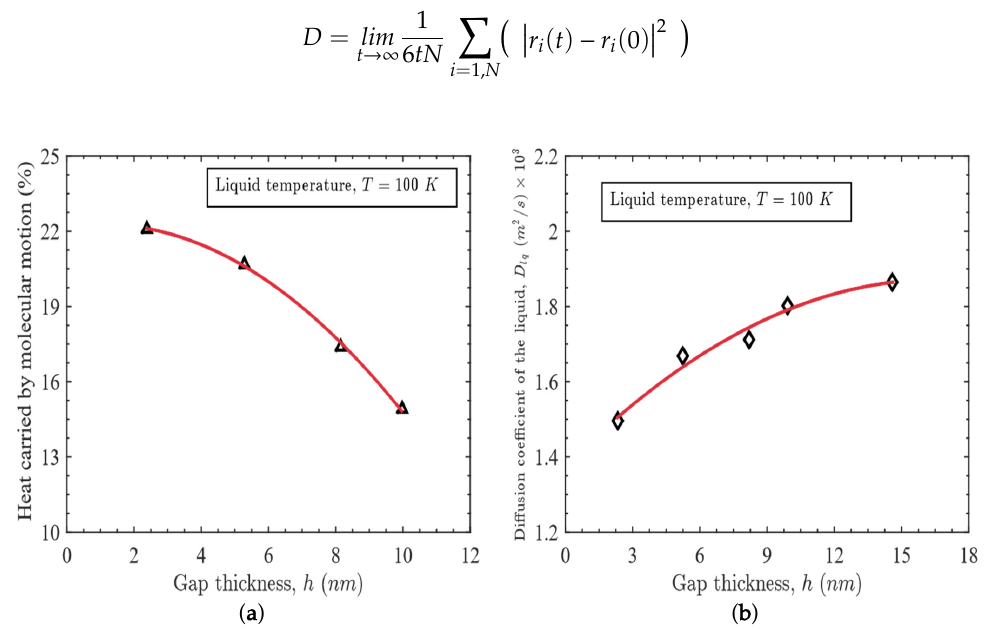
Figure 4. (a) Contribution of molecular motion in total energy transfer, and (b) diffusion coefficient of Figure 4. ( a ) Contribution of molecular motion in total energy transfer, and ( b ) di ff usion coe ffi cient of entrapped liquid under varying thickness and constant temperature. entrapped liquid under varying thickness and constant